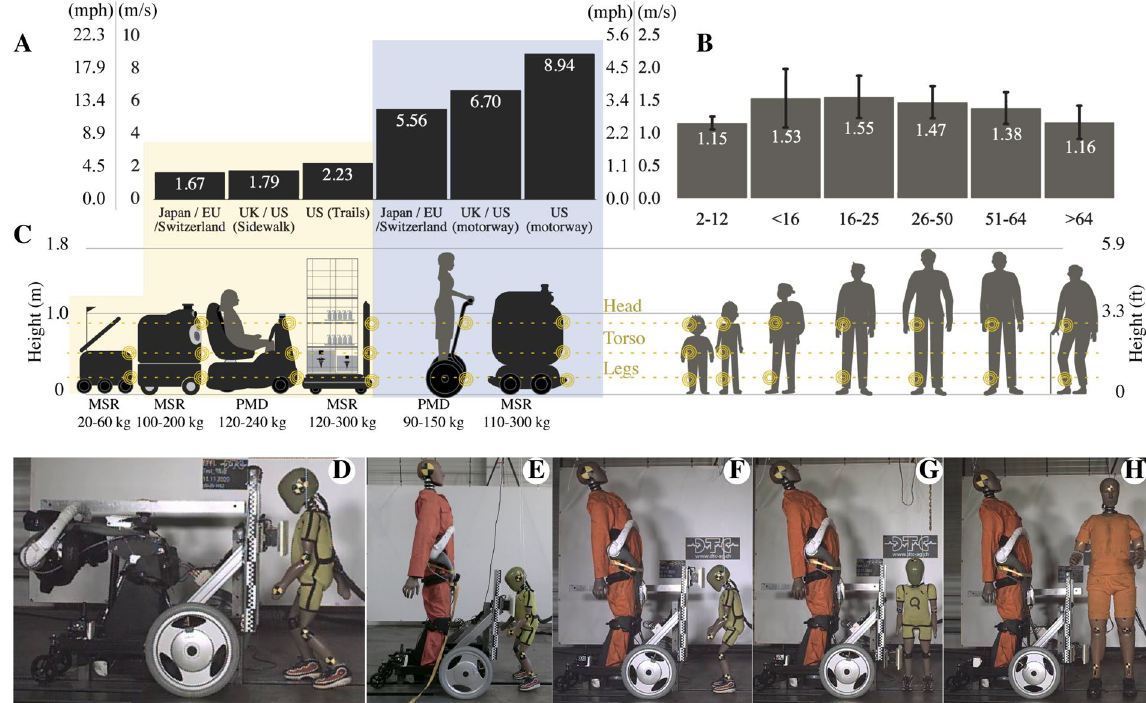
Figure 1. Pedestrians’ and robots average speed. ( A ) Normative speed for vehicles in pedestrian lanes and motorways in the US, Europe, and Japan (2021). ( B ) Pedestrians’ average walking speed from 2-year-old children to elderly adults. ( C ) Height comparison between pedestrians and mobile service robots (MSR) and personal mobility devices (PMD). ( D ) Child pedestrian collision at the thorax with a 60 kg MSR. Subsequent tests with a PMD 133 kg impacting at the child’s thorax ( E ), head ( F ), legs ( G ), and with an adult pedestrian at the lower legs ( H